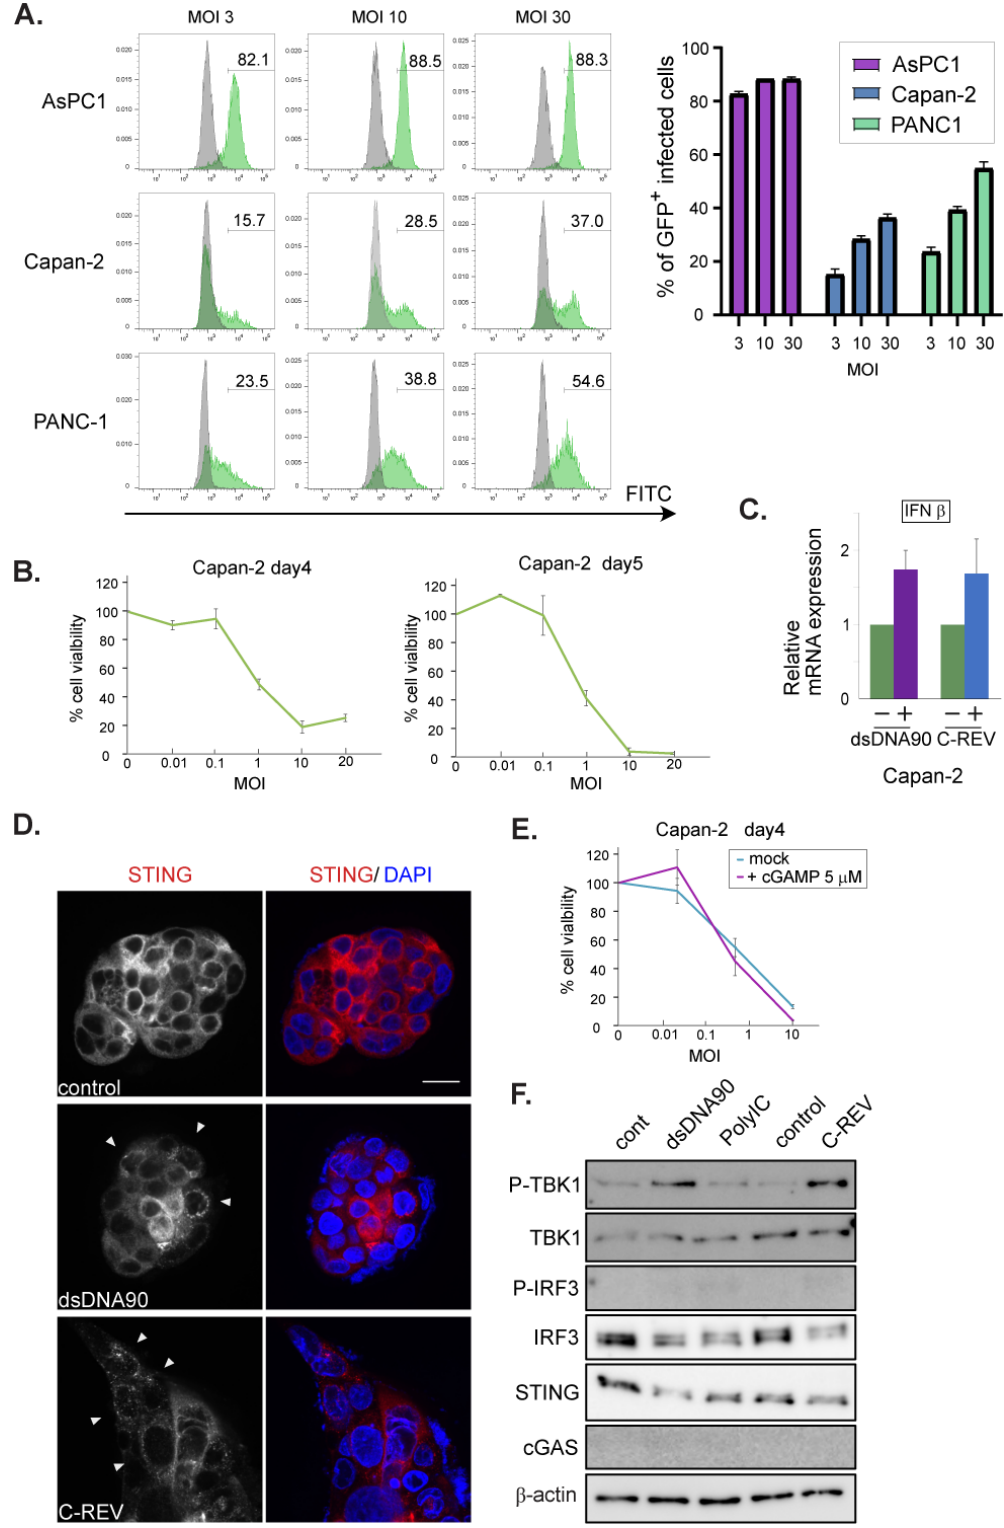
Figure 4. Low susceptibility to C-REV infection is not highly dependent on STING pathway activation in Capan-2 cell line. ( A ) Histograms of GFP+ infected cells. Respective cells were infected with C-REV-GFP at different MOIs (3, 10 and 30). After 12 h, cells were harvested and GFP was examined by flow cytometry. (right) Percentages of infected cells were calculated with the gate shown in left histograms. ( B ) Cytotoxicity of C-REV with several indicated MOI against Capan-2 cells on day 4 and day 5 by MTT assay. Data are presented as mean ± SEM of 3 independent experiments. ( C ) Induction of IFN β . At 6 h after transfection of dsDNA90 (3 μ g/mL), samples were analyzed by RT-qPCR. IFN β expression was